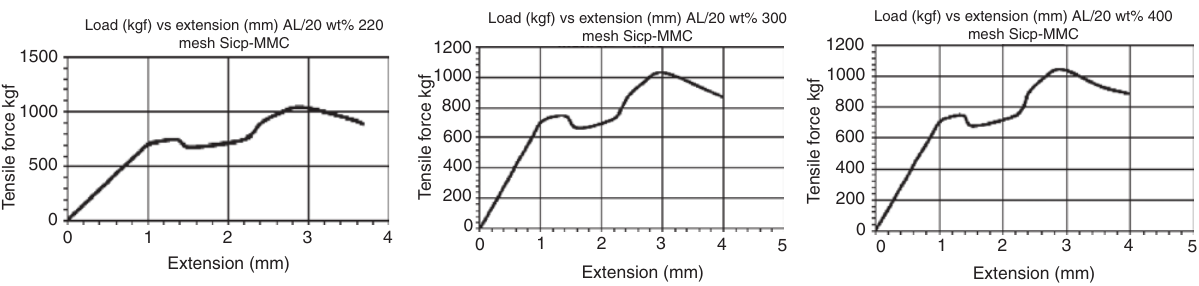
Figure 2: Load versus elongation curve for MMC Al/20% SiCp. Reproduced with permission from Science and Education Publishing